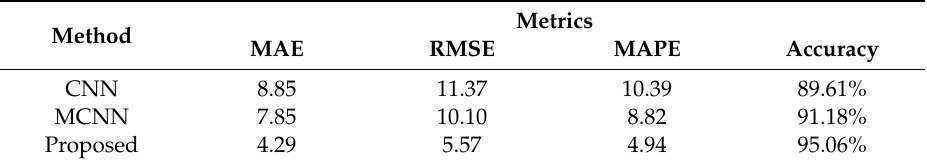
Table 3. Comparison results of different methods.